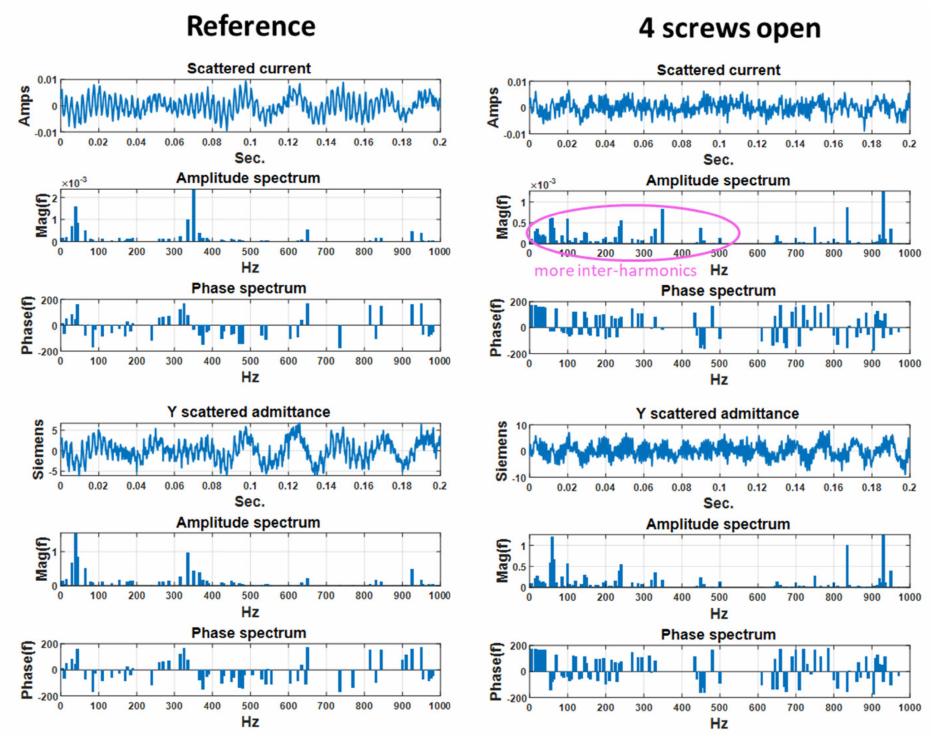
Figure 16. Loaded AC motor setup. Load is performed with a DC motor. CPC distinguishing signatures: normalized ‘scattered’ current and